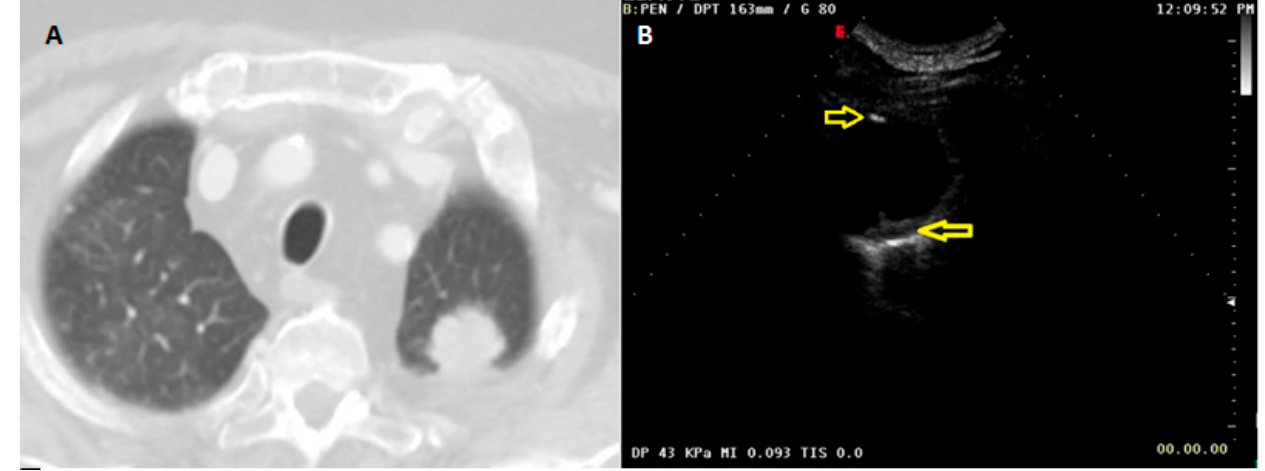
Figure 6. ( A ) Axial chest CT scan (lung window) showing a subpleural malignant pulmonary lesion in the apicoposterior segment of the left upper lobe. ( B ) US scan with contrast setting (mechanical index: 0.093), but without the administration of contrast agent, displaying hyperechogenic spots inside the lesion (yellow arrows) which could be confused with CE AT.